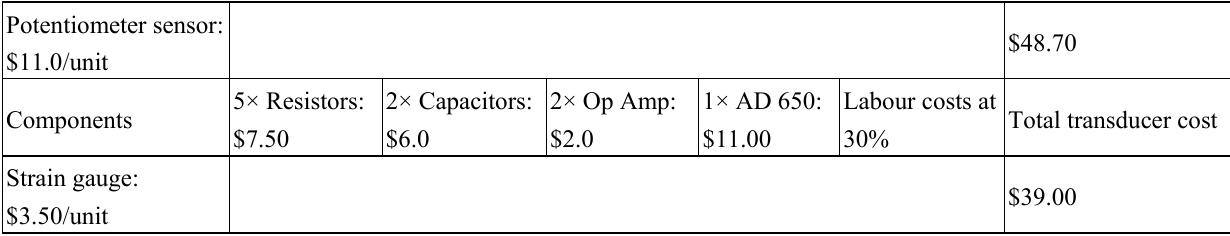
Table 5. Cost analysis per unit of the millimeter-to-frequency transducer.